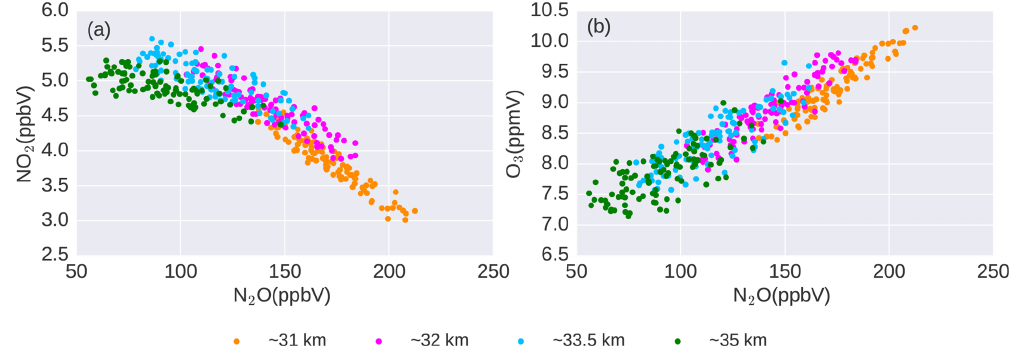
Figure 4. Scatter plots of monthly mean (a) N 2 O versus NO 2 and (b) N 2 O versus O 3 in the tropical mid-stratosphere during January 2004– April 2012 from TOMCAT simulation CNTL. Colour coding classifies data according to altitude: 31km (orange), 32km (magenta), 33.5km (sky blue), and 35km